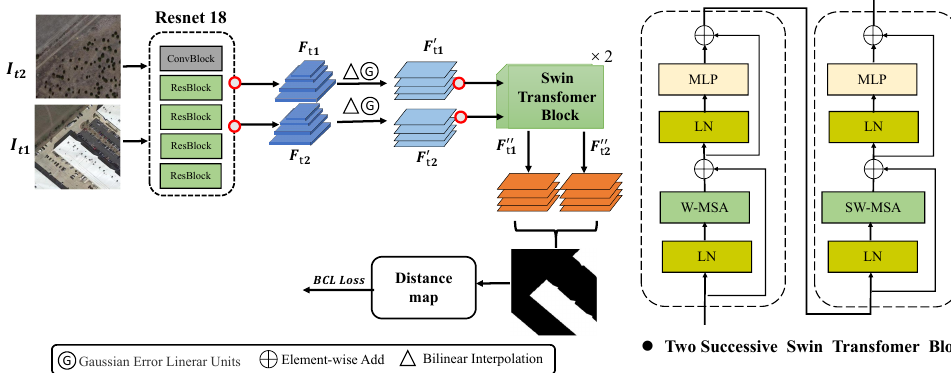
Figure 3. Change Detection based on swin transformer block on remote sensing